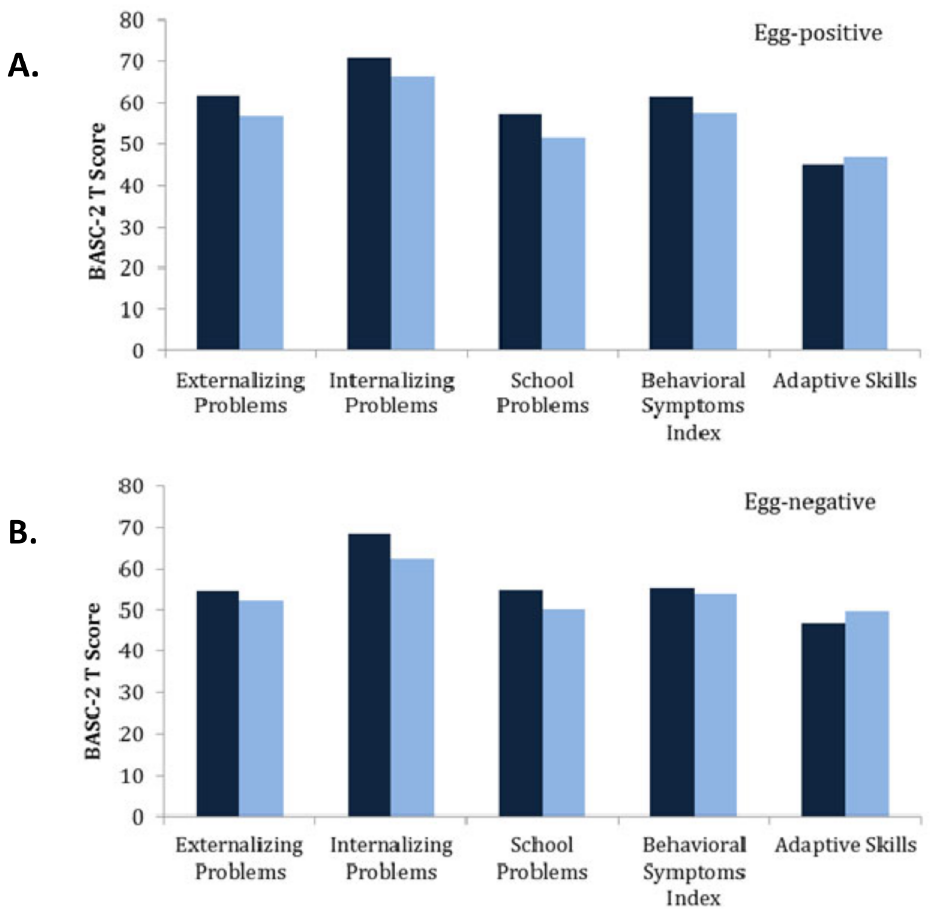
Fig 1. Mean BASC-2 T scores for S . mansoni egg-positive (Panel A) and egg-negative (Panel B) students before and after treatment with praziquantel. The results of the BASC-2 survey were transformed into standardized T scores for each of 5 composite behavior categories. The mean T scores for each group of students were then determined;the numericalvalues and standarddeviationsare listed in S1 Table. A lower score indicates fewer problematic behaviorsfor externalizingproblems, internalizingproblems, school problems, and the Behavioral Symptoms Index. A higherscore indicatesmore favorablebehaviors for AdaptiveSkills. dark blue = before treatment; light blue = after